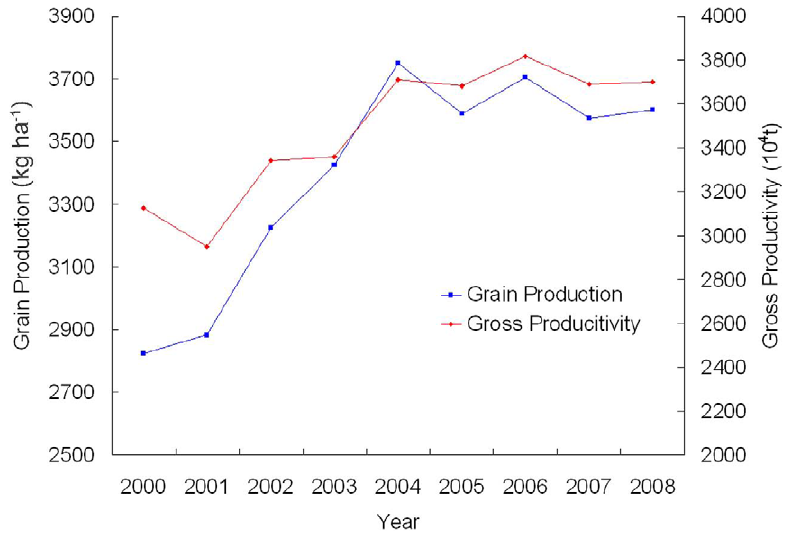
Figure 8. Grain and gross production change from 2000 to 2008 in the Loess Plateau region.